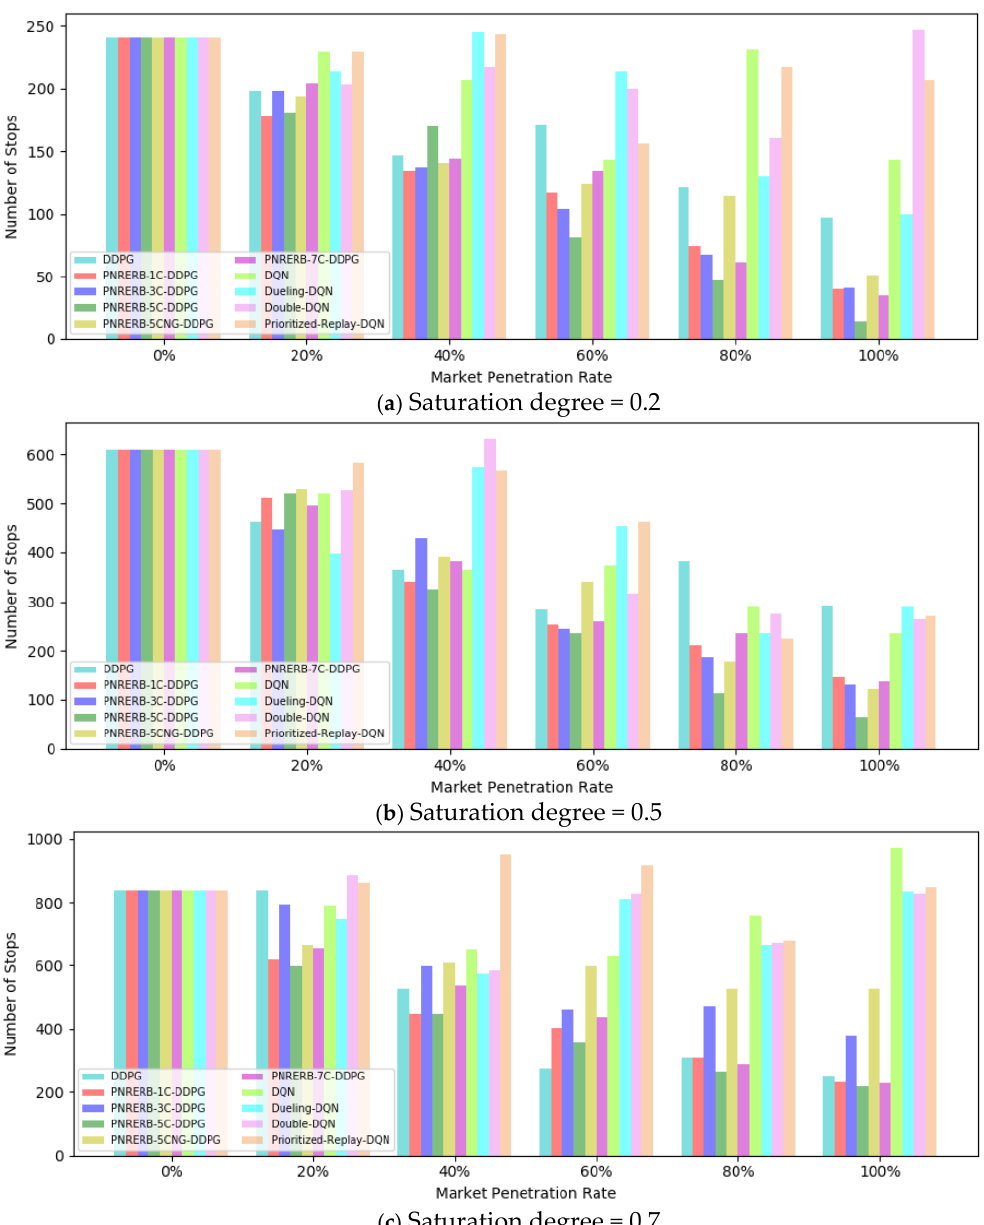
Figure 7. Comparison diagram of number of stops under different CAV MPRs under saturation degrees of 0.2/0.5/0.7.